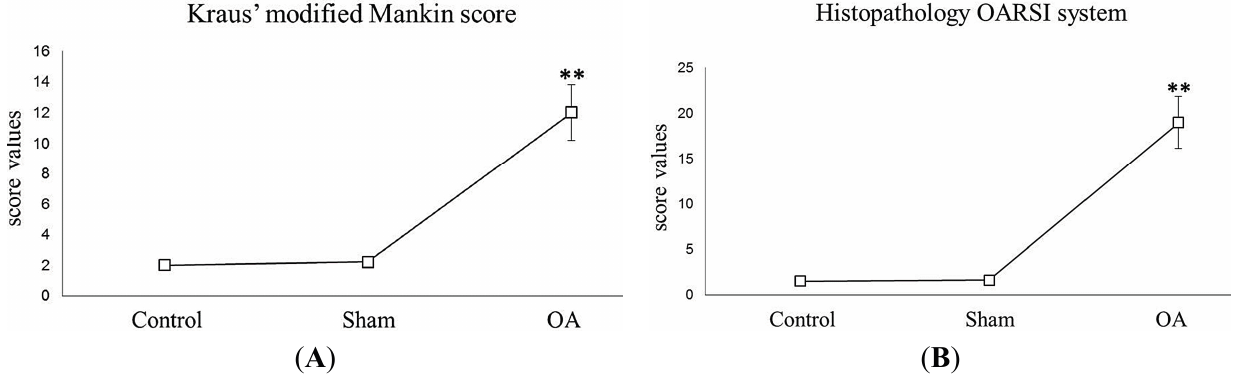
Figure 1. Graph A , Kraus’ modified Mankin score. Kraus’ modified Mankin score